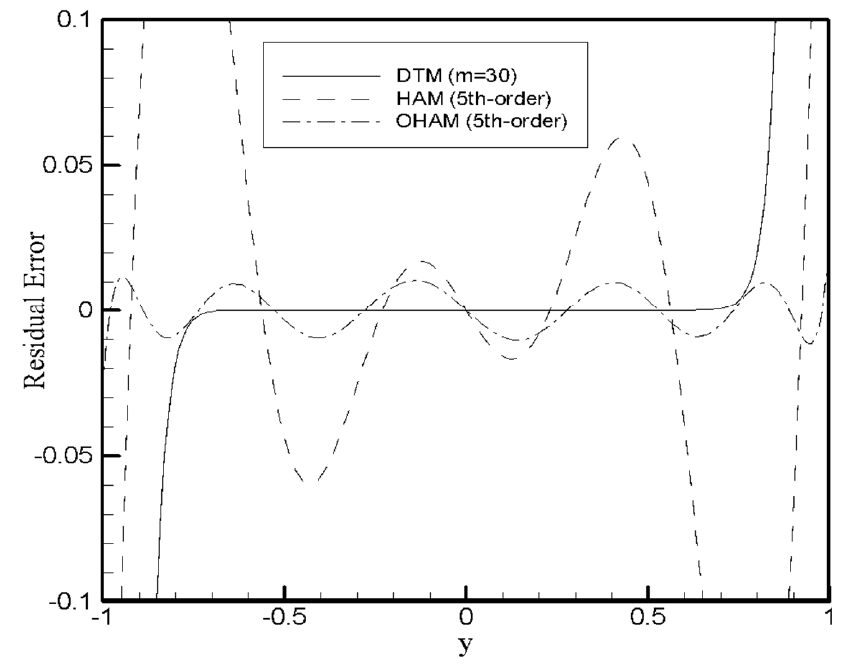
Figure 7. Residual error of different approaches for the case of Re = 5 and α = 1.